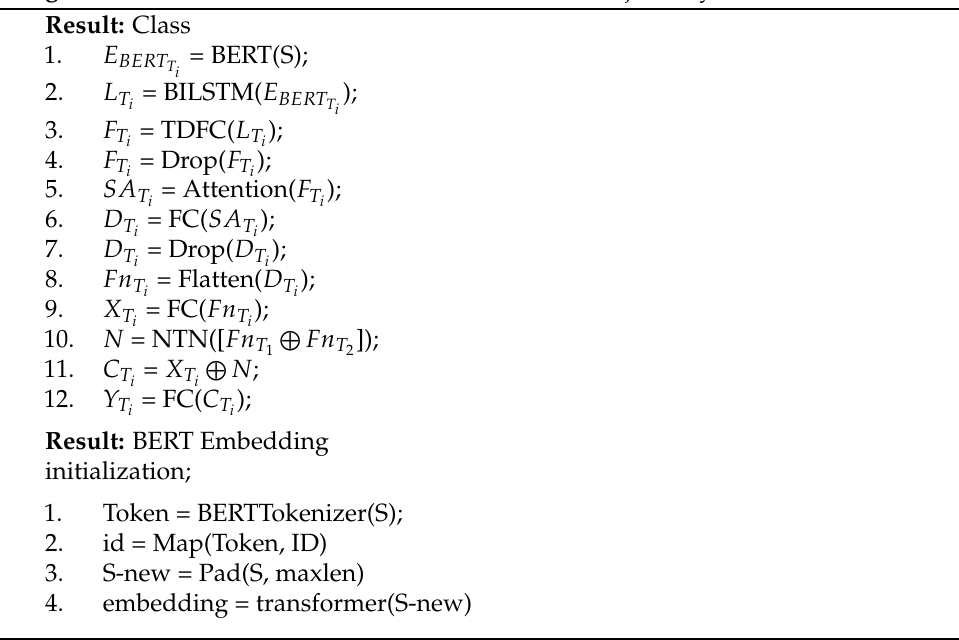
Figure 1. Framework of our proposed model. Algorithm 1: Multitask BERT based Sentiment and